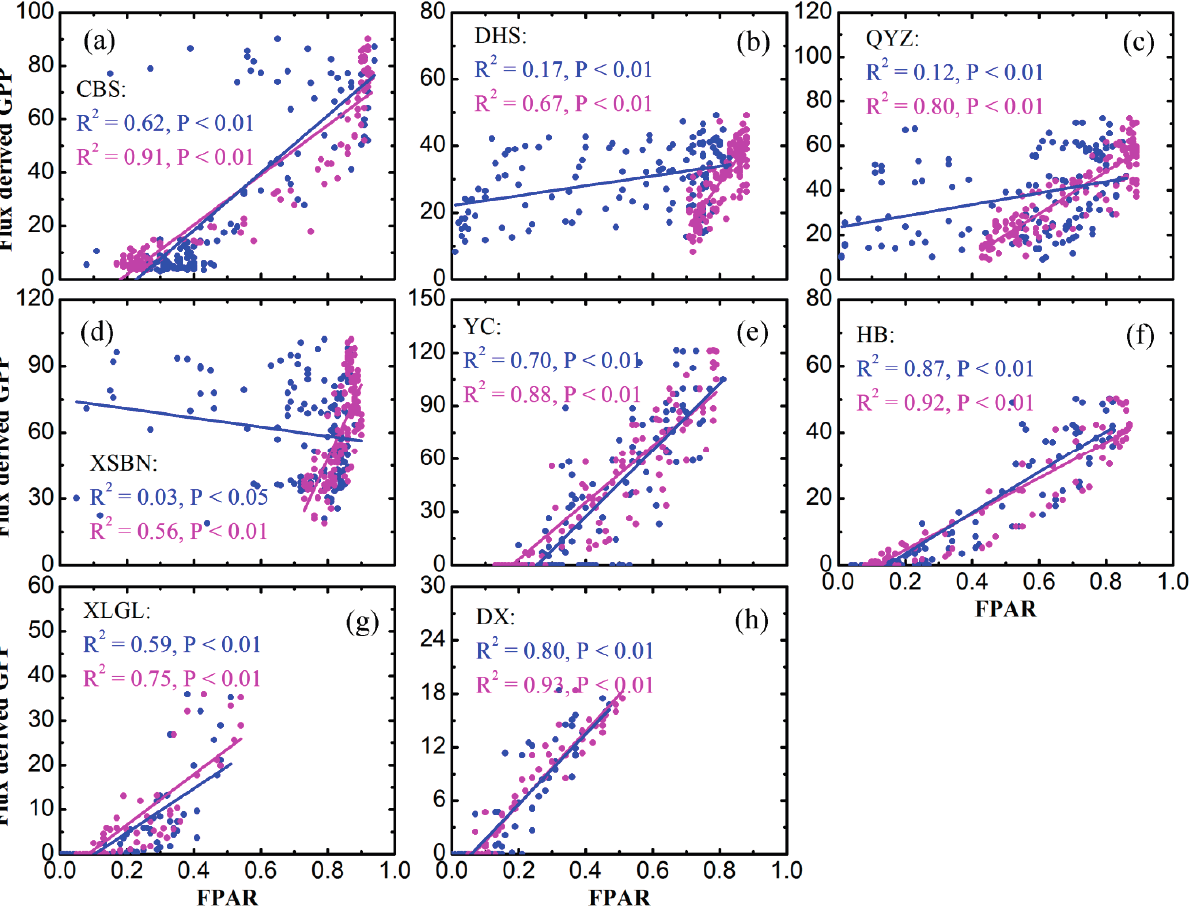
Figure 4. Relationship between flux derived GPP (with gC/m 2 /8-day) and GLASS-FPAR (pink)/MODIS-FPAR (blue) for each site. ( a ) in mixed forests site; ( b ) in evergreen broadleaf forests site; ( c ) in evergreen needleleaf forests site; ( d ) in evergreen broadleaf forests site; ( e ) in croplands site; ( f , g , h ) in grasslands